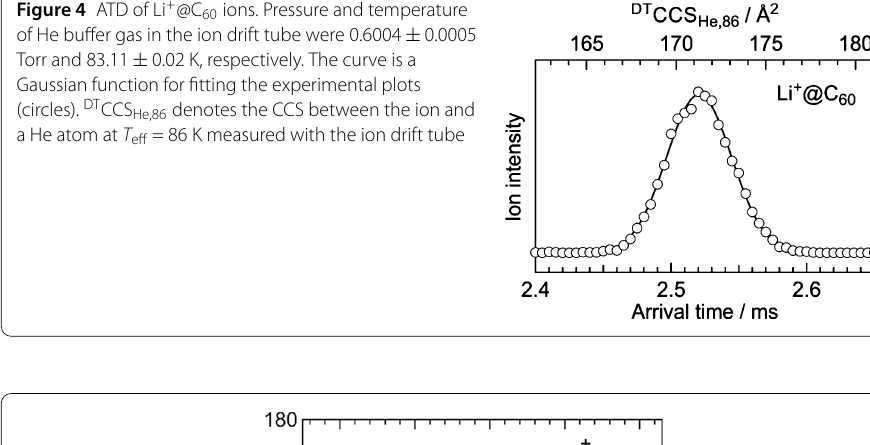
Figure 4 ATD of Li + @C 60 ions. Pressure and temperature of He buffer gas in the ion drift tube were 0.6004 ± 0.0005 Torr and 83.11 ± 0.02 K, respectively. The curve is a Gaussian function for fitting the experimental plots (circles). DT CCS He,86 denotes the CCS between the ion and